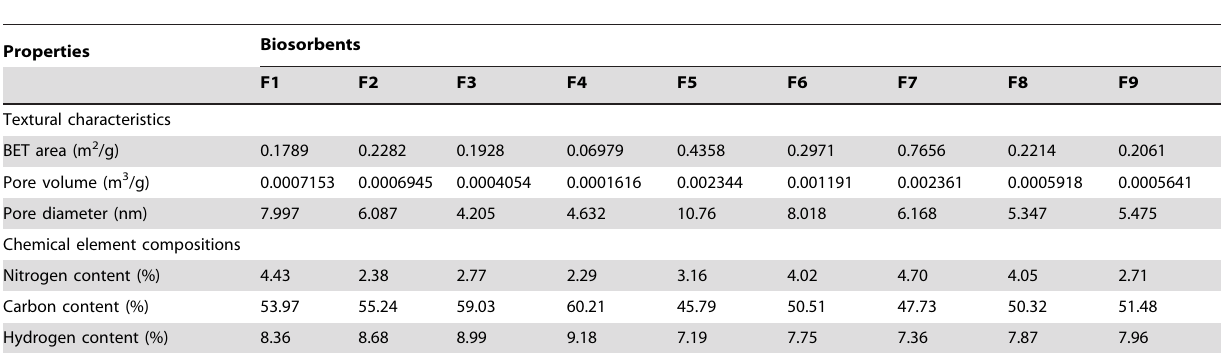
Table 5. Textural characteristics and chemical element compositions of biosorbents.